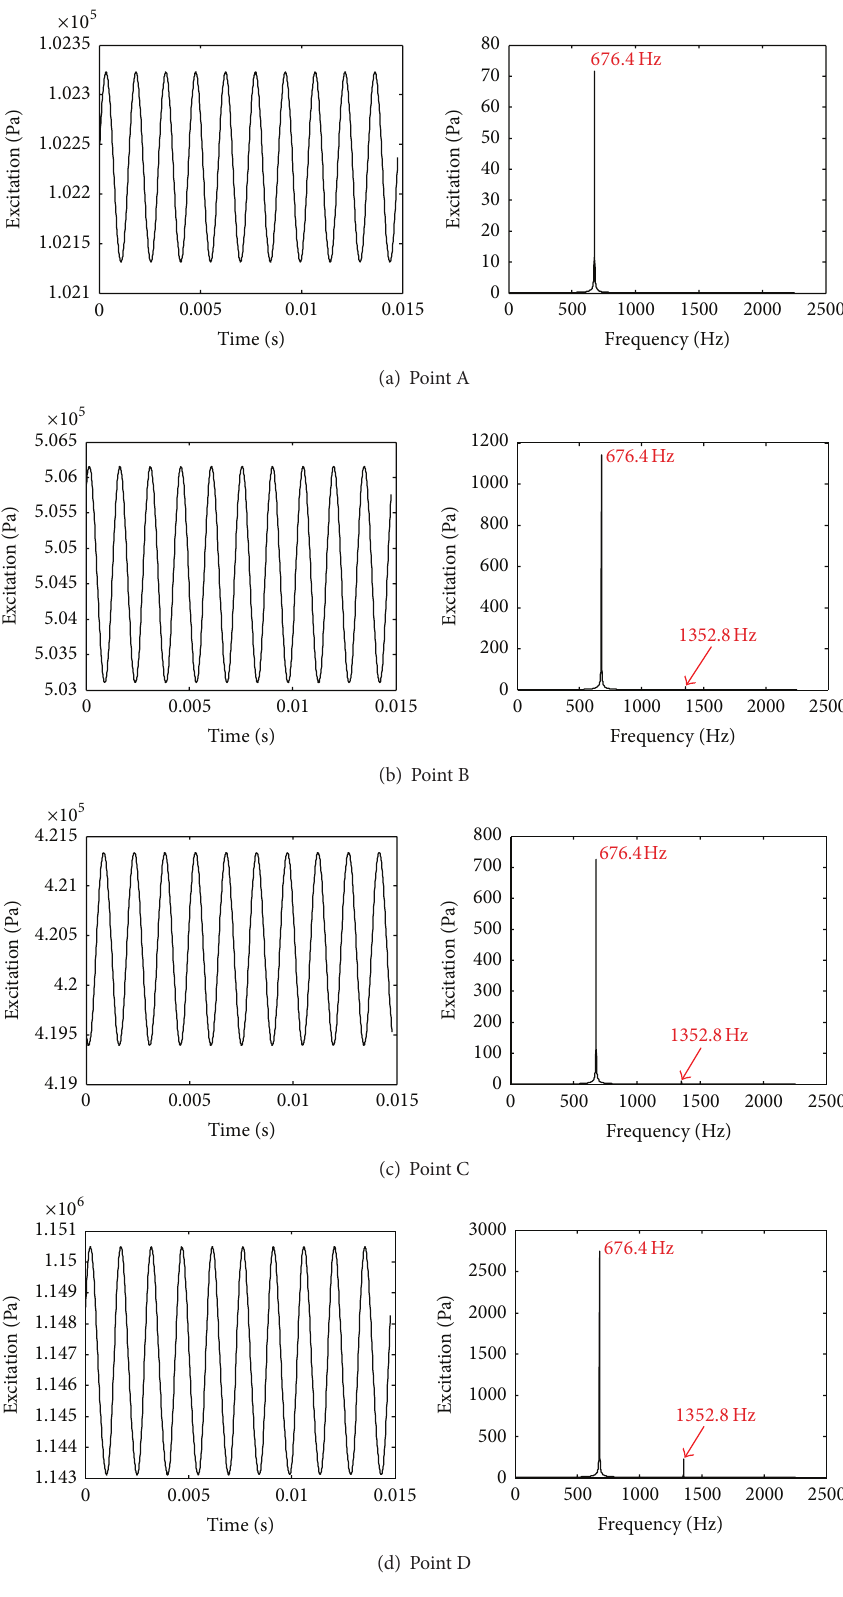
Figure 11: Pressure pulsation time history and spectrogram on every key point of Rampressor rotor